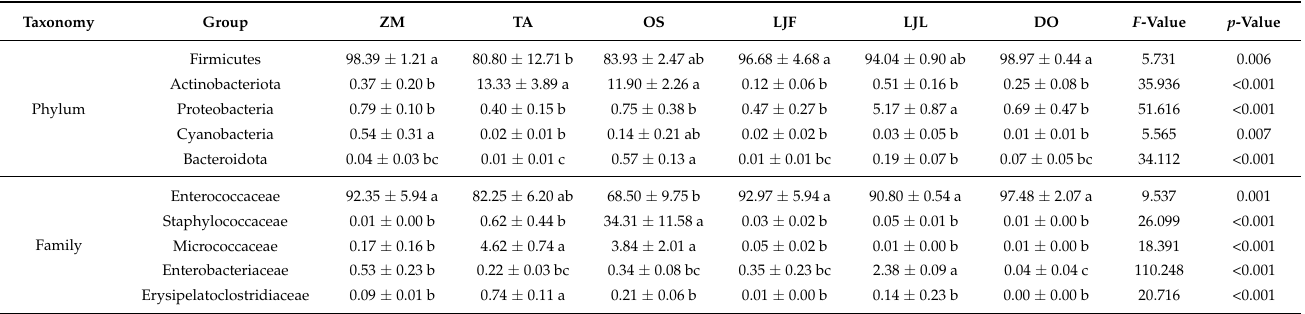
Table 1. The relative abundance of dominant bacteria at the phylum and family taxonomic levels in Spodoptera frugiperda fed on different hosts.